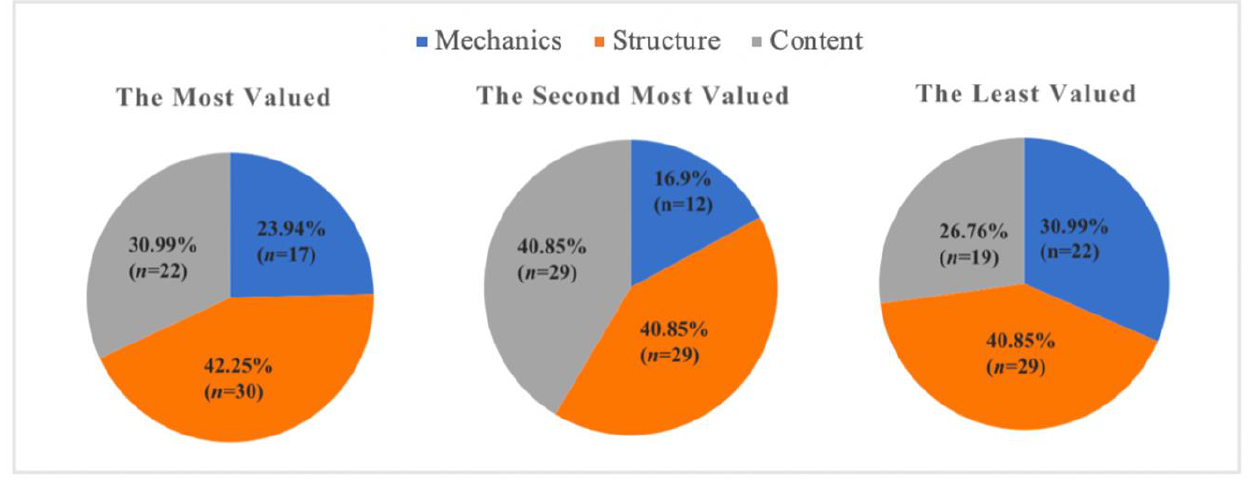
Figure 2. Students’ Preferences for Feedback on Writing Mechanics, Structure, and Content. Table 1. Examples of the Teacher’s Written Corrective Feedback.